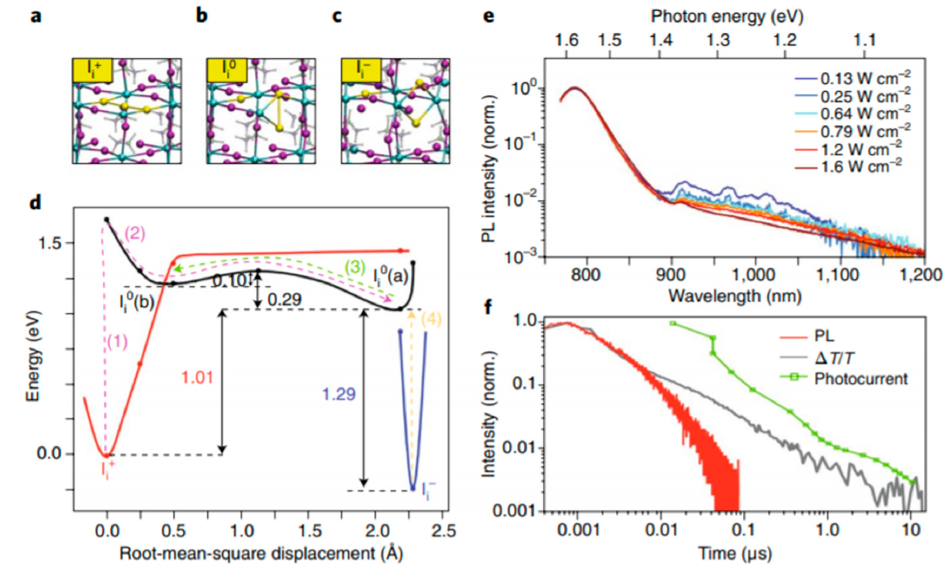
Figure 9. Interstitial iodine defects as hole and electron traps in MAPbI 3 . Local geometrical structures of interstitial iodine ( a ) as a cation I + , ( b ) as a neutral atom, I, and ( c ) as iodide, I − . ( d ) Potential energy landscapes related to species in ( a ), ( b ) and ( c ). Root mean square displacement of iodine atom with respect to the position of I i + . Dots are calculated points, lines are interpolated. ( e ) Steady-state photoluminescence (PL) spectra with increasing excitation fluence, showing enhanced near infrared (NIR, ~1000 nm) emission at low excitation powers. ( f ) Photoluminescence dynamics probed at 1.56 eV, together with photocurrent decay and transient absorption kinetics. Reproduced with permission from Energy Environ. Sci. 2018 , 11 , 702–713. Reference [22] as well as Reproduced with permission